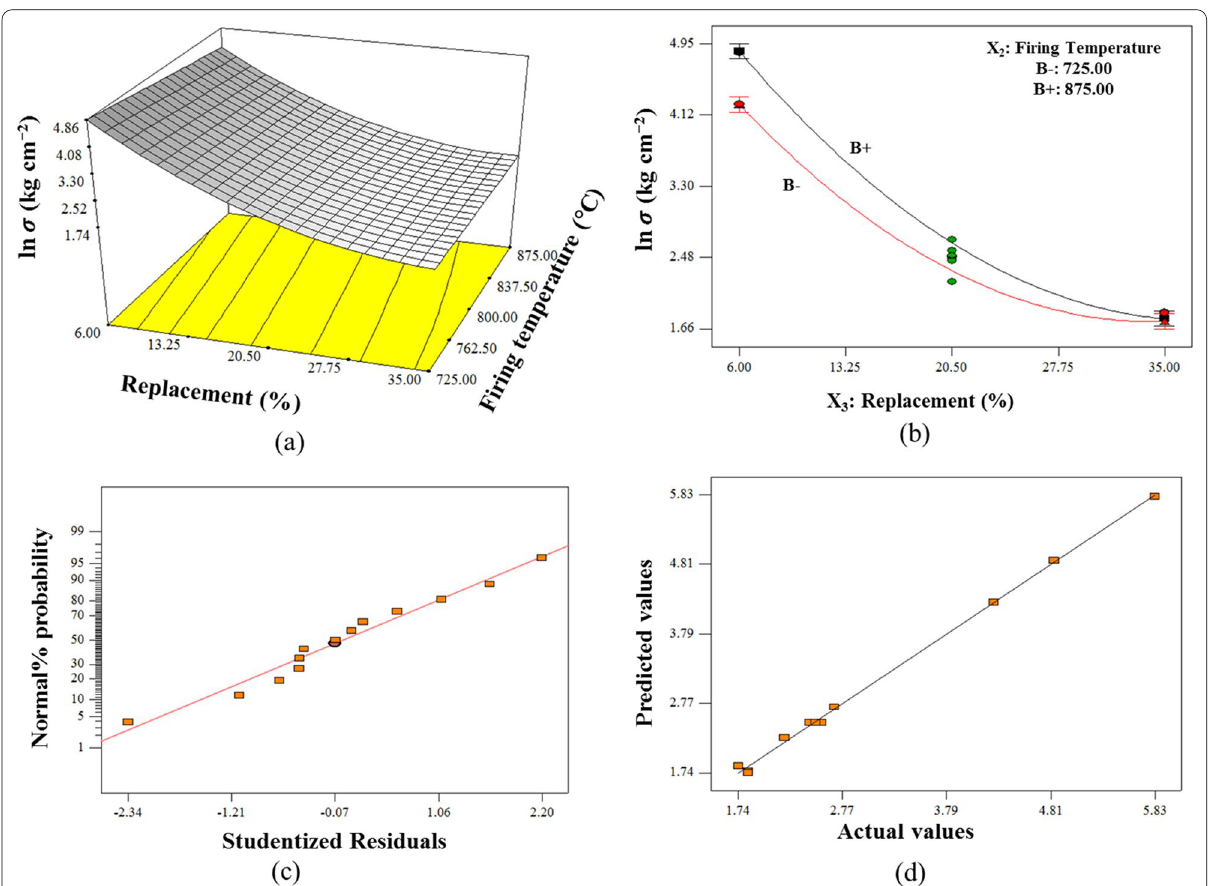
Fig. 9 Clay‑PB fired bricks: a model 3D graph, b model contour, c normal plot of the residuals, and d actual values of the response versus the predicted values